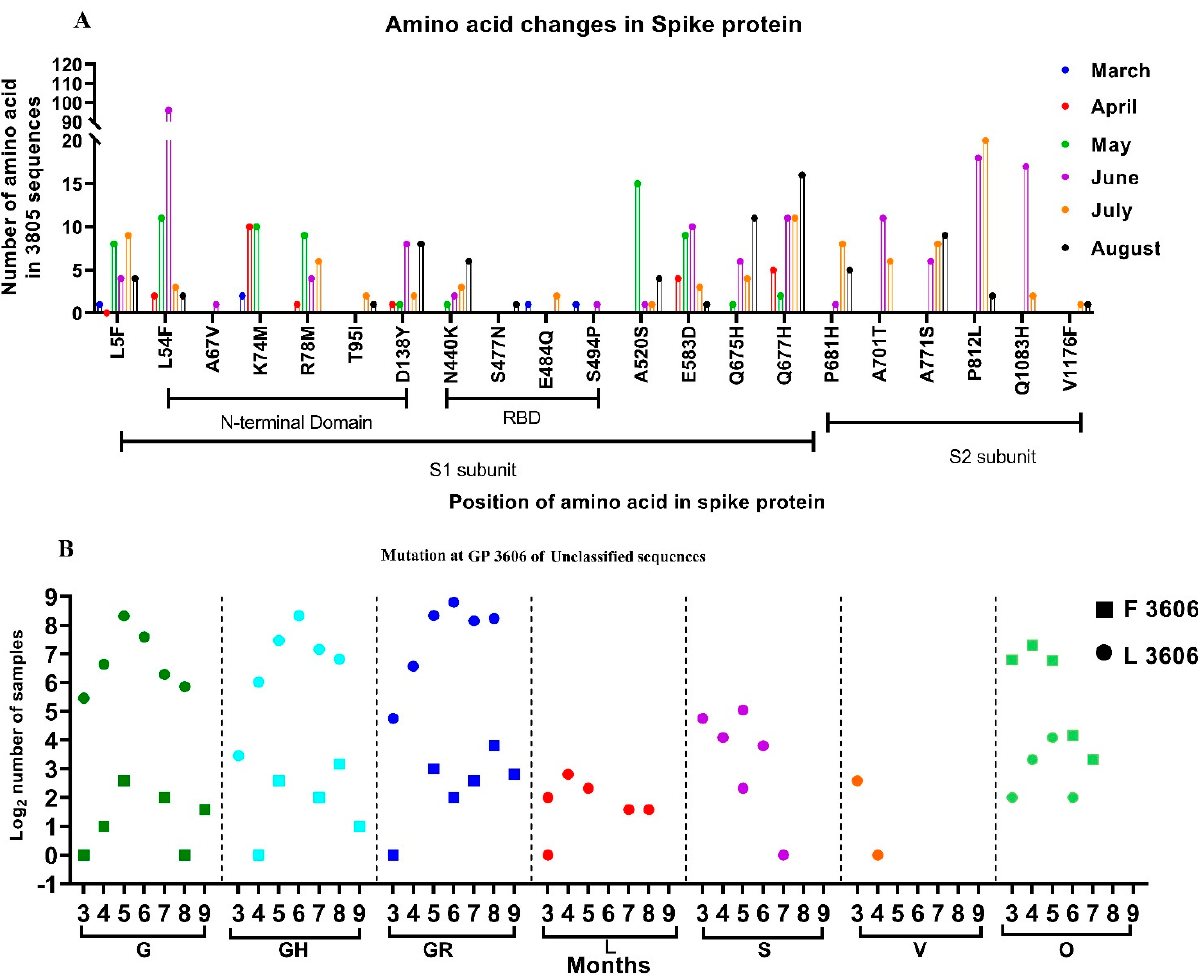
Figure 2. Month-wise changes in the mutations observed in SARS-CoV-2 sequences: ( A ) Month-wise changes in the amino acid mutations in the spike protein that were observed in more than 0.5% of the samples studied. ( B ) Month-wise changes in the Leucine and Phenylalanine amino acids at GP 3606, position 3606, observed within different clades.